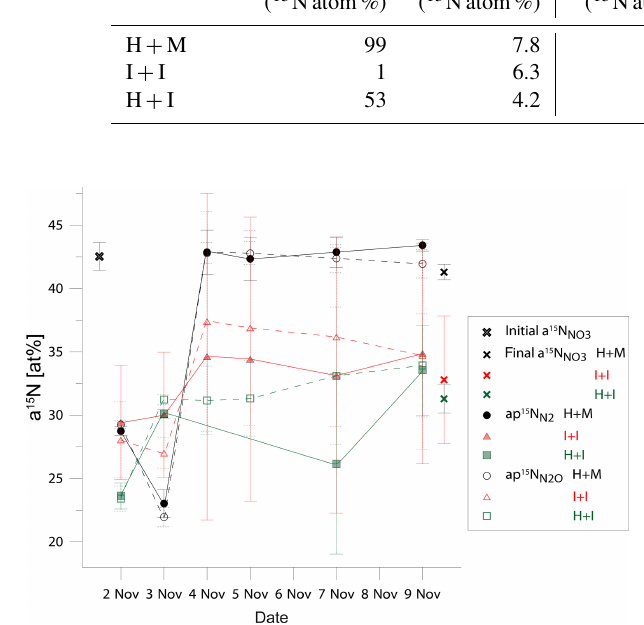
Figure 2. Comparison of 15 N abundance in total initial and final soil nitrate ( a 15 N NO ) and in active soil pool emitting N 2 ( a 15 3 and N 2 O ( a 15 N N ) in three treatments: homogenized soil and P 2 O mixed fertilizer (H + M, black points)), intact soil core and injected fertilizer (I + I, red points), homogenized soil and injected fertilizer (H + I, green